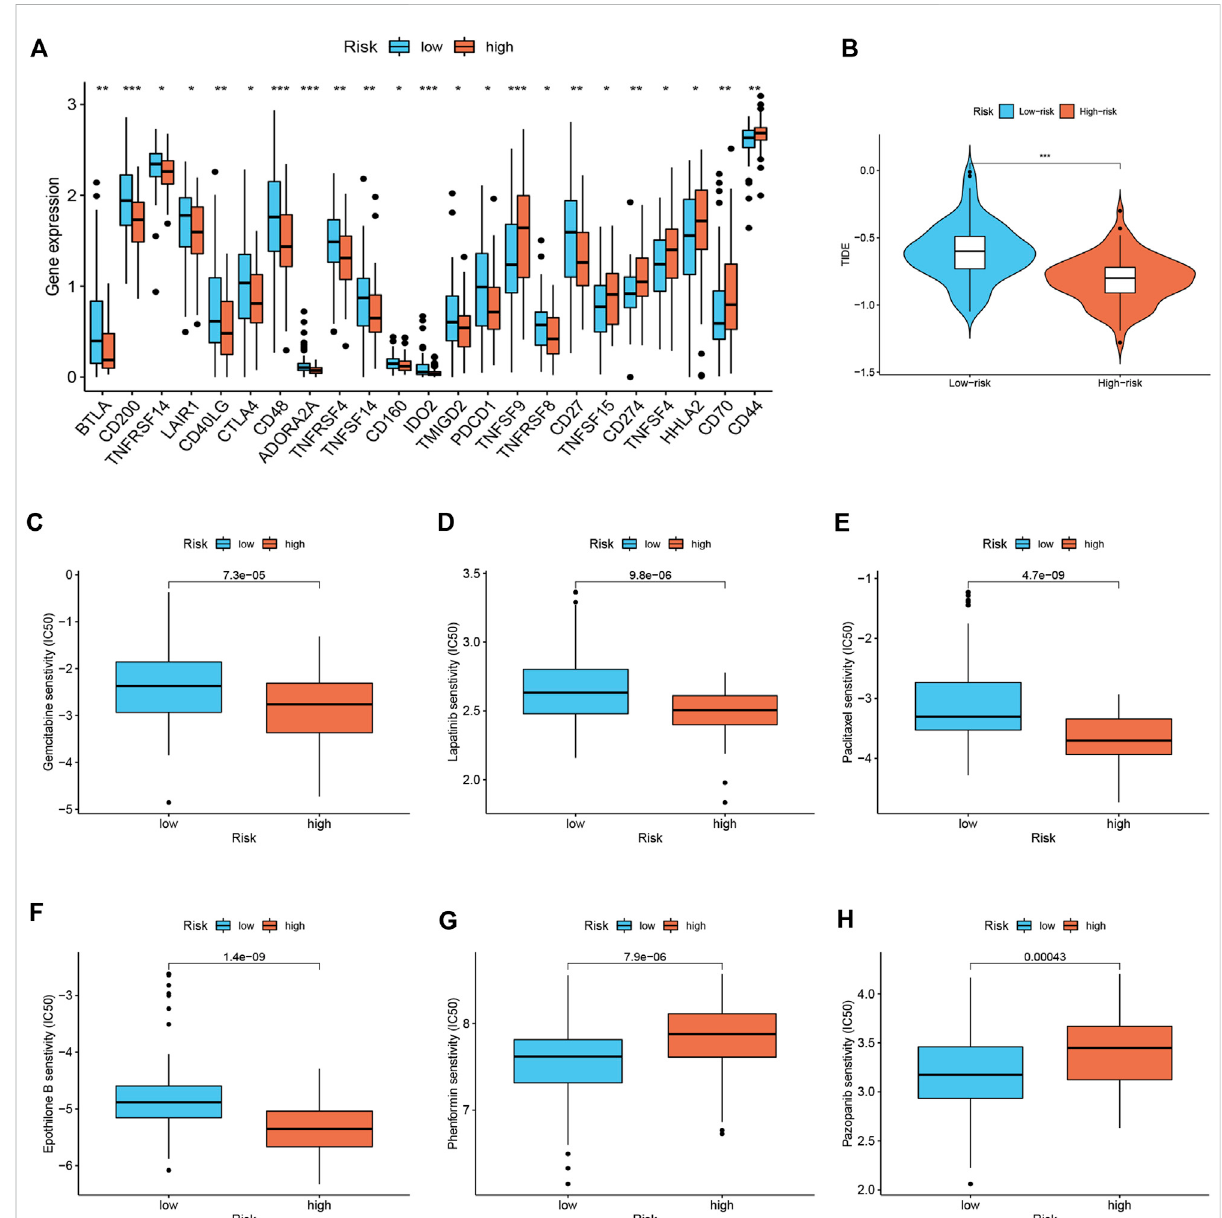
FIGURE 5 Immune therapeutic evaluation of and chemotherapeutic drug selection ( n = 170). (A) Differences in immune checkpoint among different risk subgroups. (B) Comparison of TIDE score between low- and high-risk groups. (C – H) Comparison of potential therapeutic drug susceptibility of different risk subgroups assessed by